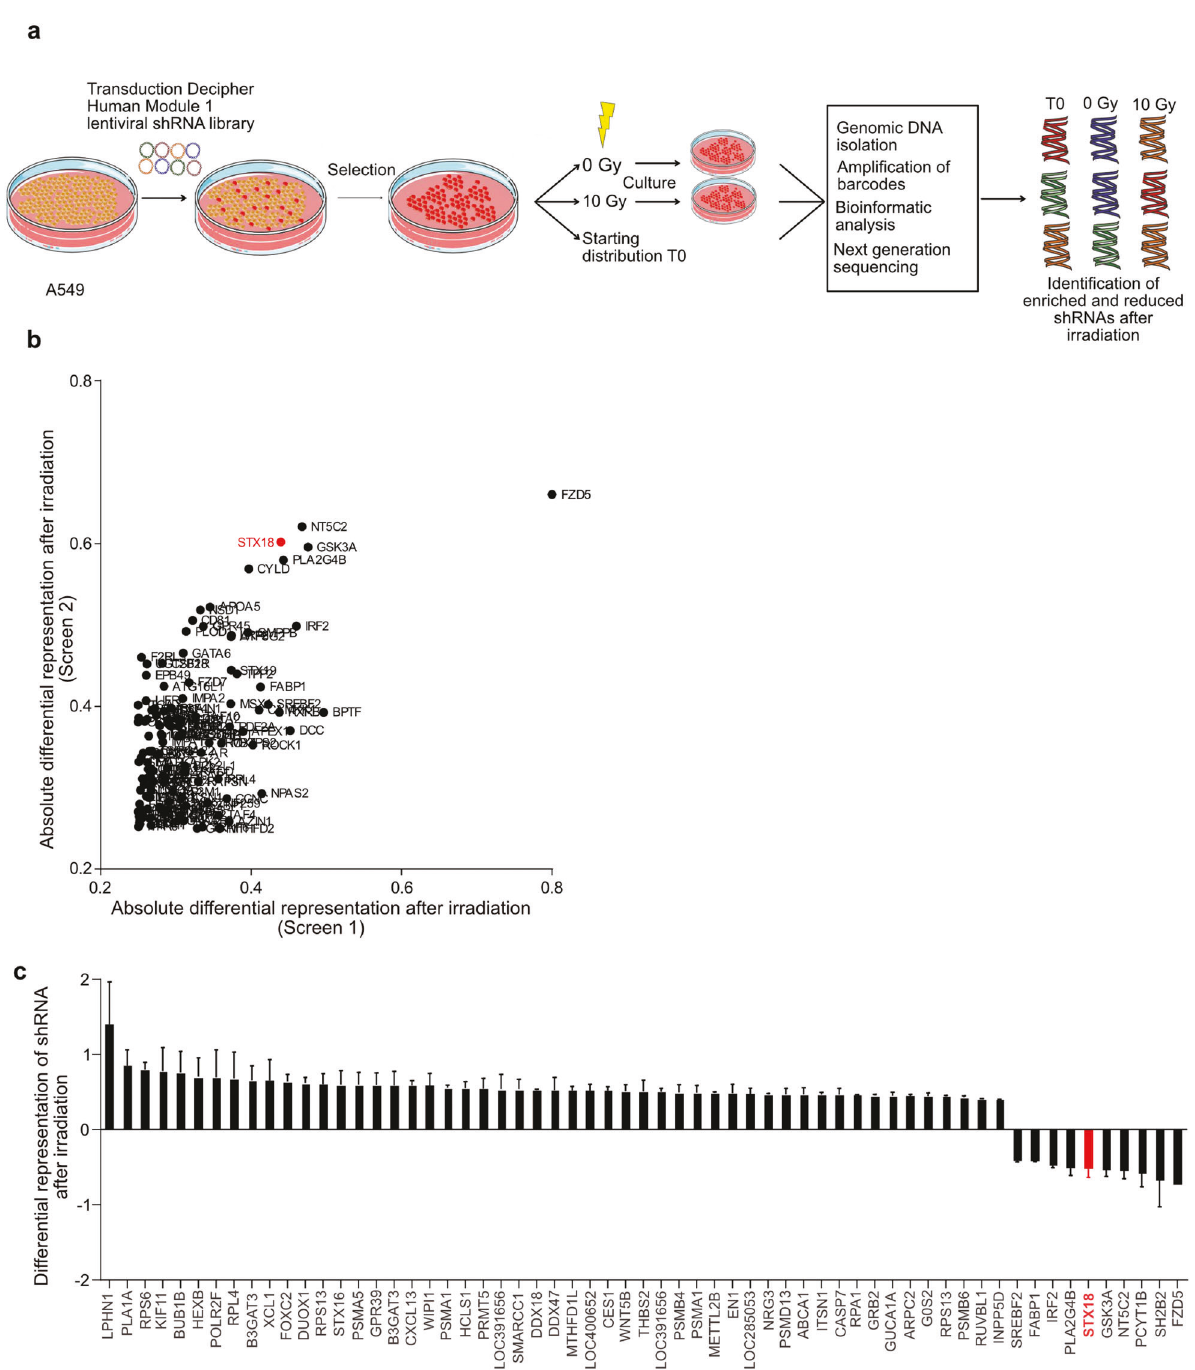
Fig. 1 An in vitro shRNA screen identi fi es STX18 as a modulator of radiosensitivity in A549 cells. a A549 cells were transduced with the DECIPHER shRNA library Human Module 1, comprising 27500 pooled shRNA with a transduction ef fi ciency of 30% and cells were selected with puromycin. After 5 days, cells were pooled and either frozen, irradiated with 10 Gy or not irradiated. DNA was then isolated and sequenced. Analysis distinguished barcodes that were enriched or reduced after irradiation. n = 2. b Differential representation of individual shRNA with highest reduction after irradiation in both repetitions of the screen. Data were normalized to shRNA representation in the initial cell population. c Normalized differential expression of the most enriched and reduced shRNA after irradiation. Data were normalized to shRNA representation in the initial cell